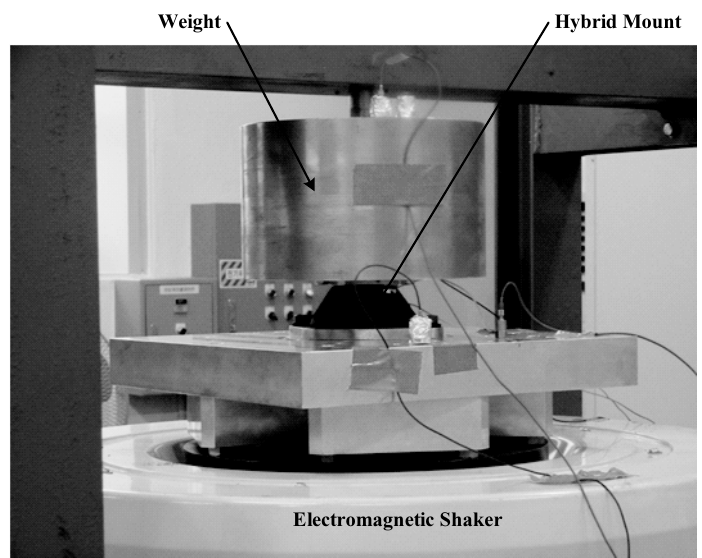
Fig. 16. Photograph of transmissibility test using electromagnetic shaker.